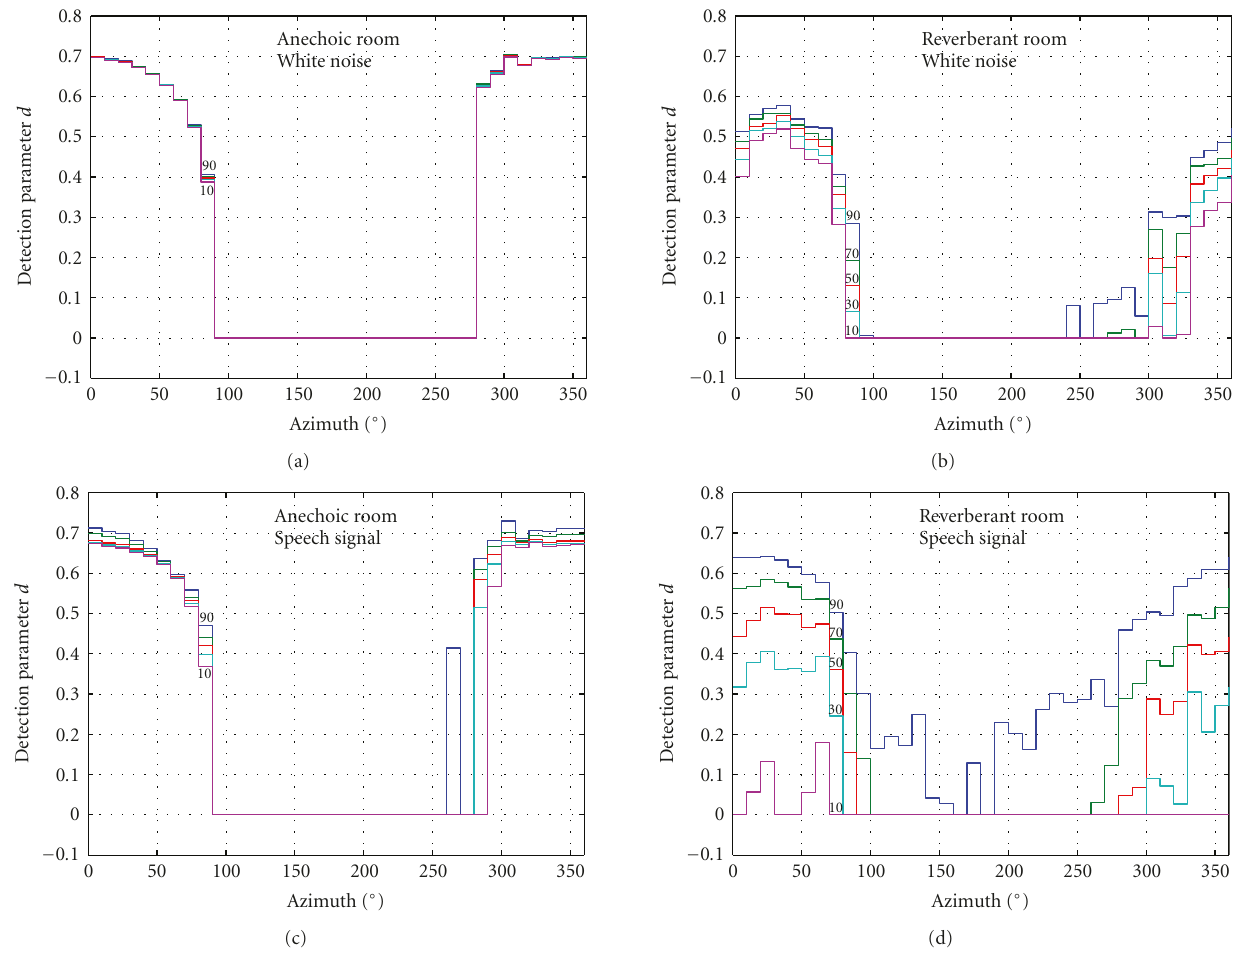
Figure 5: Performance of the multicorrelation target signal detection algorithm in simulated anechoic and reverberant environments as a function of the direction of incidence of the signal using either a white noise source or a speech signal. Percentiles denote the percentage of time, during which the detection parameter d was lower than value